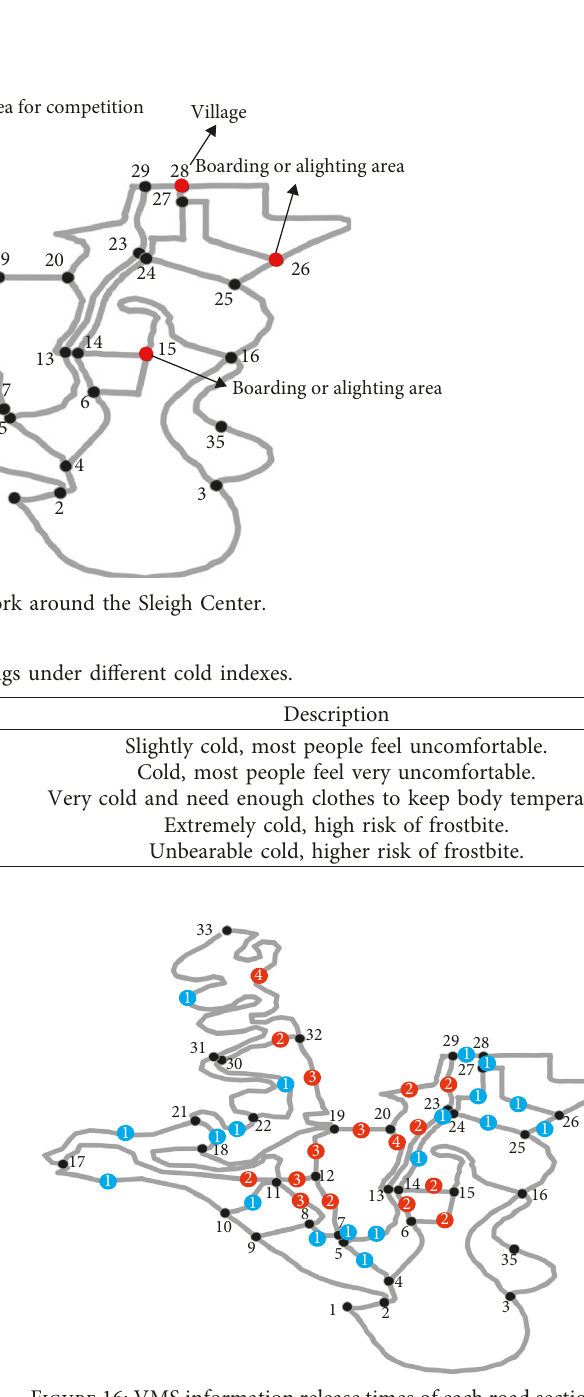
Figure 15: VMS information release times of each road section for the scenario of ingress.